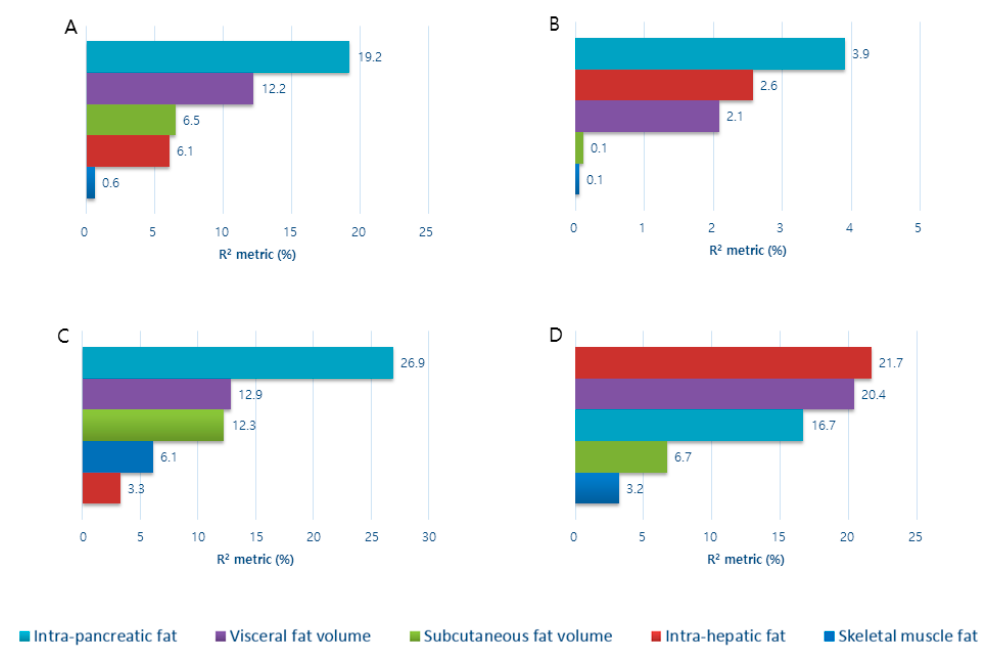
Figure 1. Contribution of the studied fat phenotypes to variance in indices of insulin sensitivity in non-obese individuals with NODAP. Data are presented as a percentage of the corresponding abdominal fat phenotype that explains the variance of ( A ) HOMA-IS; ( B ) Raynaud index; ( C )